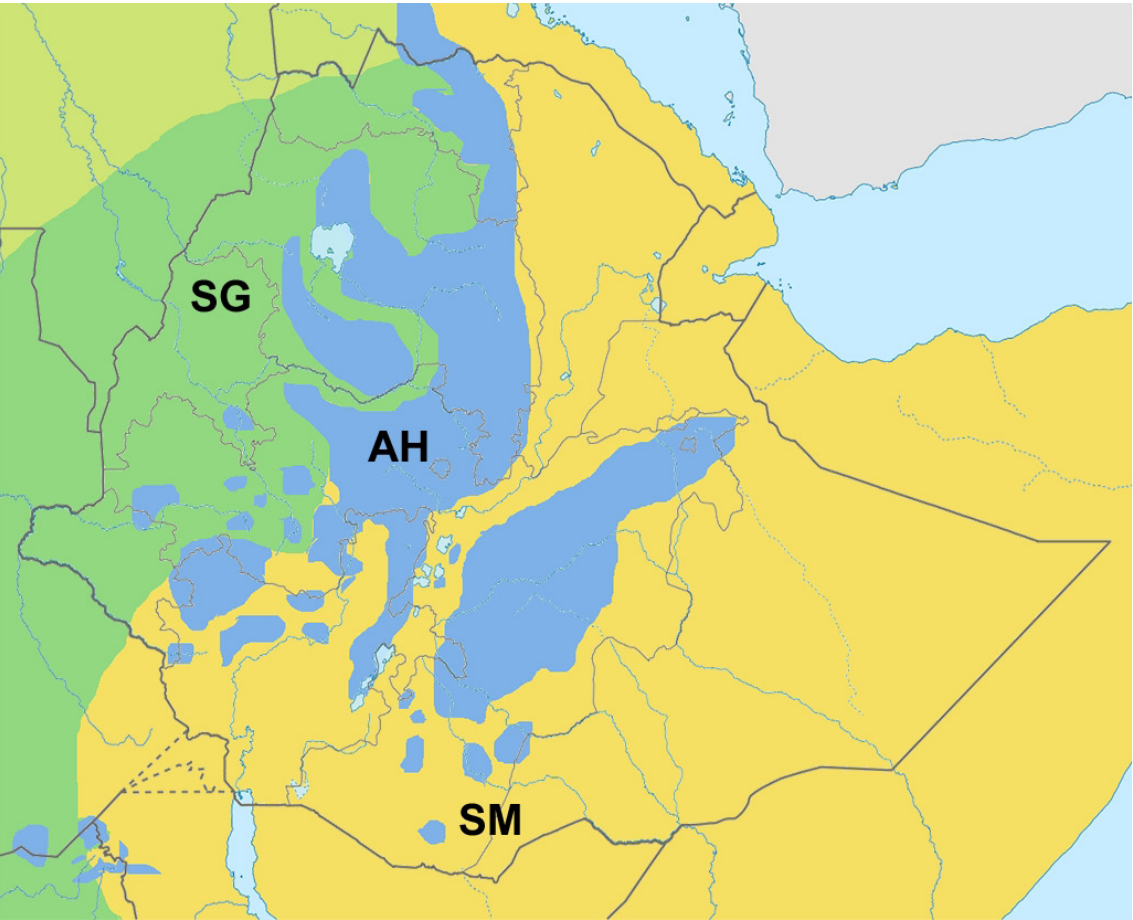
Fig. 2. Biomes in the Horn of Africa following Fishpool & Evans (2001). SG = Sudan-Guinea Savanna biome (green); AH = Afrotropical Highlands biome (blue); SM = Somali-Masai biome